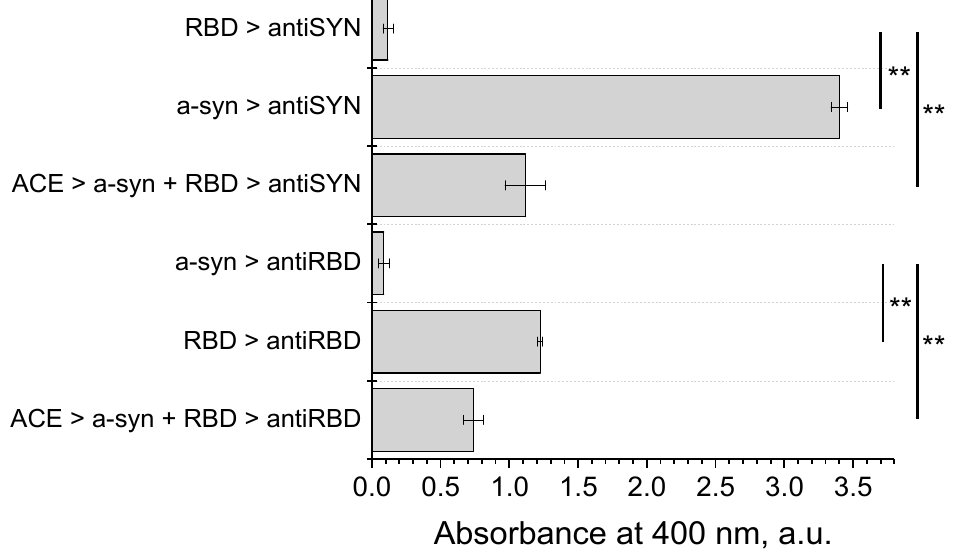
Figure 3. ACE2 interacts with pre-incubated SARS-CoV-2 RBD and alpha-synuclein by modified ELISA. Pre-incubated alpha-synuclein and SARS-CoV-2 S1 RBD during 1 h at 20 °C was applied to ACE2-Fc and detected by anti-RBD (5308) and anti-alpha-synuclein (LB509) antibodies. The poles represent the mean value of three independent measurements and error bars show the standard deviation. P-value represents results of one-way ANOVA; ** p < 0.01.